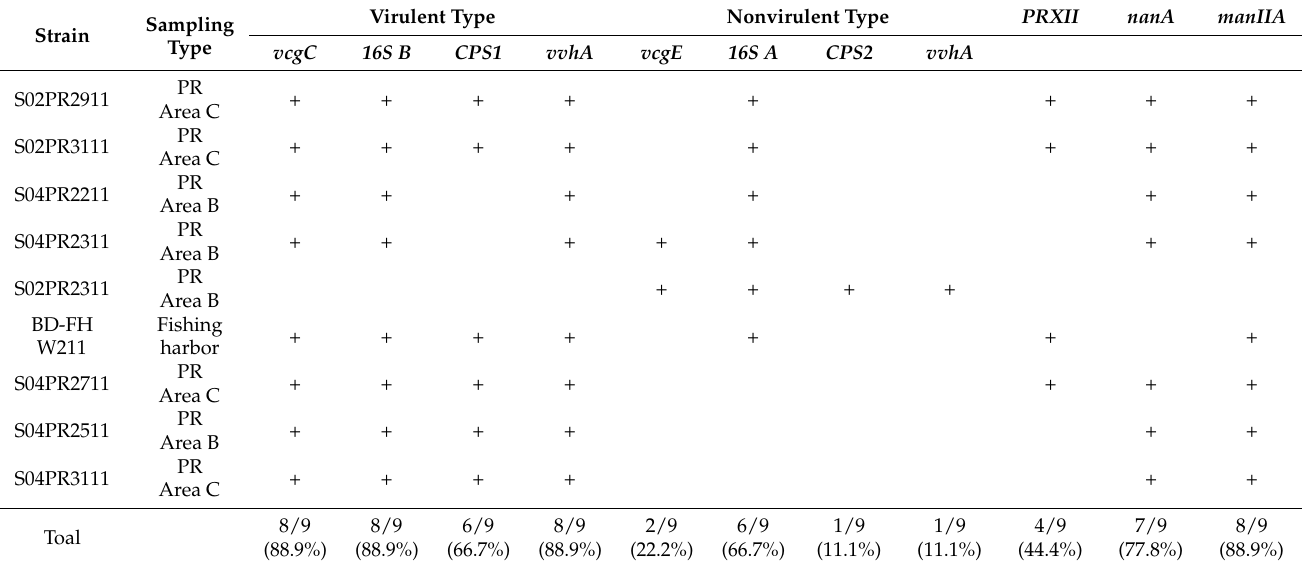
Table 3. Percentages of Vibrio vulnificus strains carrying various virulent and nonvirulent genes. Sampling Strain